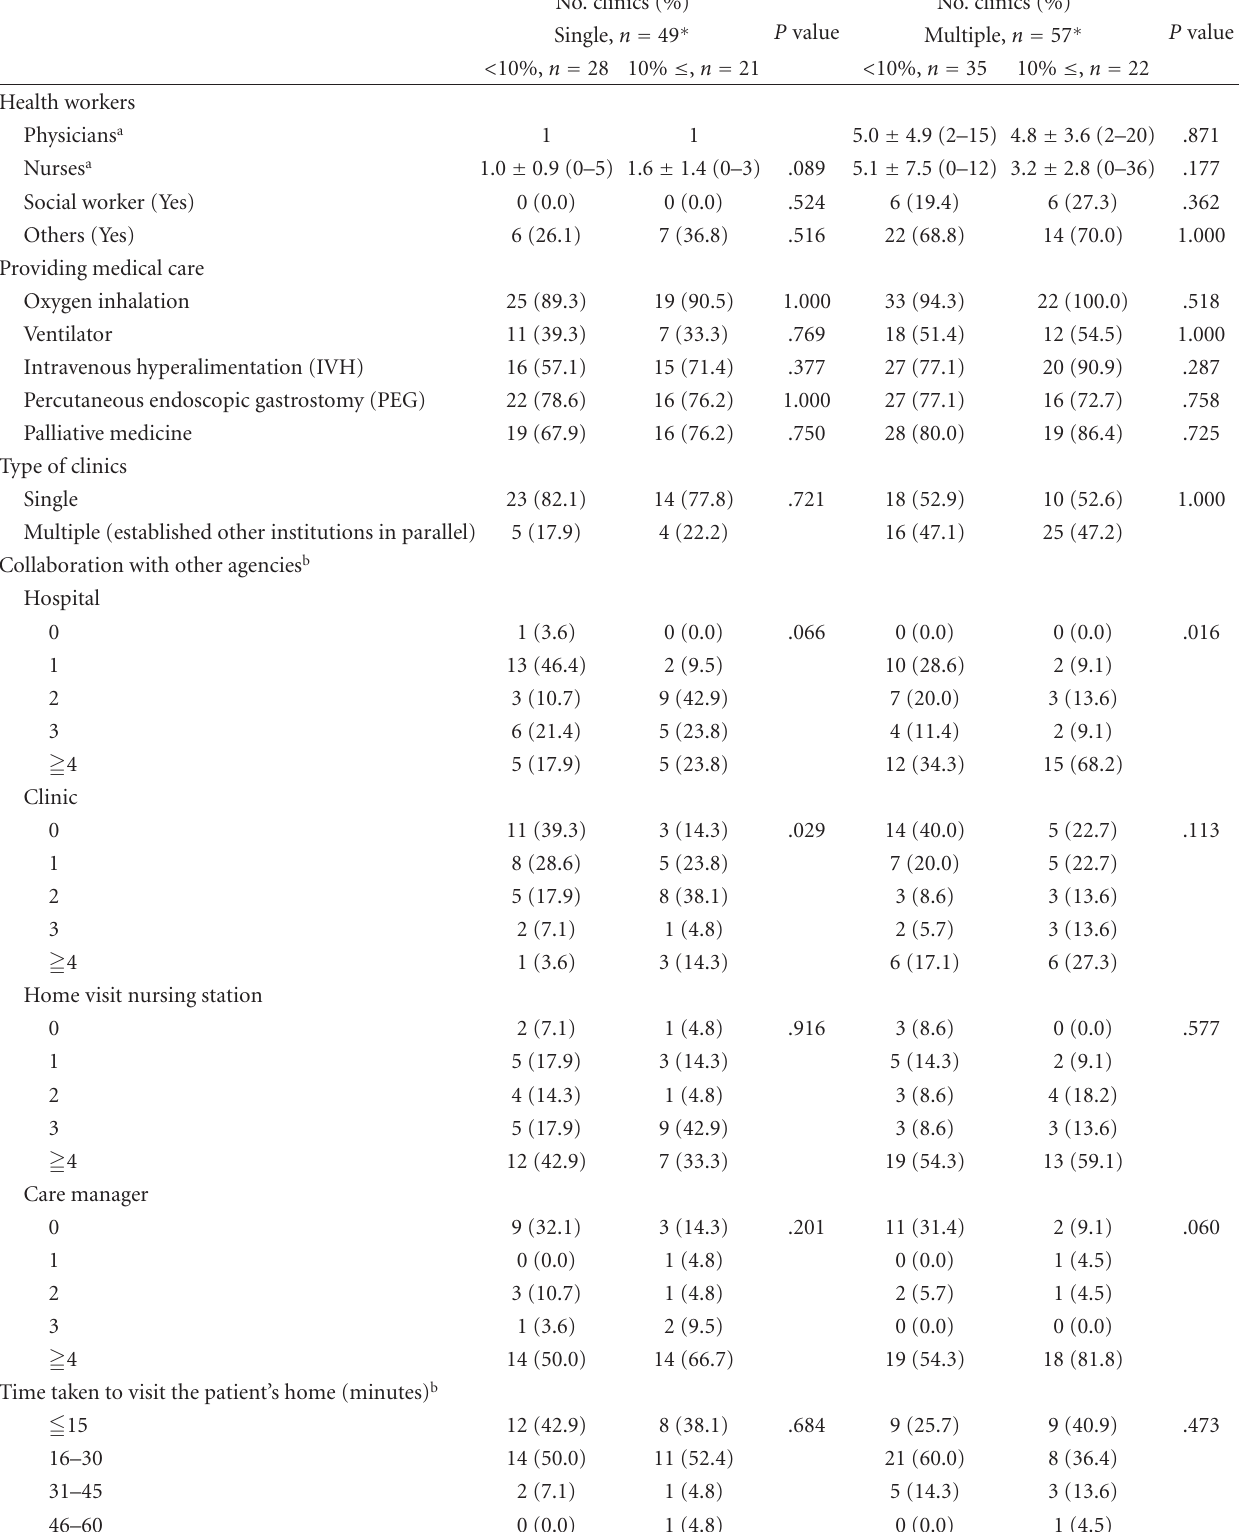
Table 3: Relationship between the proportion of home deaths and characteristics of the